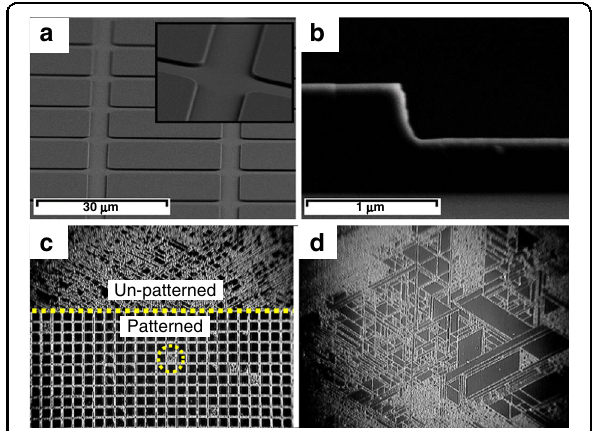
Fig. 20 Reduced area epitaxy for the growth of AlGaN photodetector pixels. a SEM image of patterned AlN, mesa size: 26 μ m × 26 μ m, periodicity: 30 μ m. b Cross-sectional SEM image of sidewall. Implemented AlGaN UV photodetector grown on patterned ( c ) and unpatterned ( d ) AlN template. Reprinted with permission